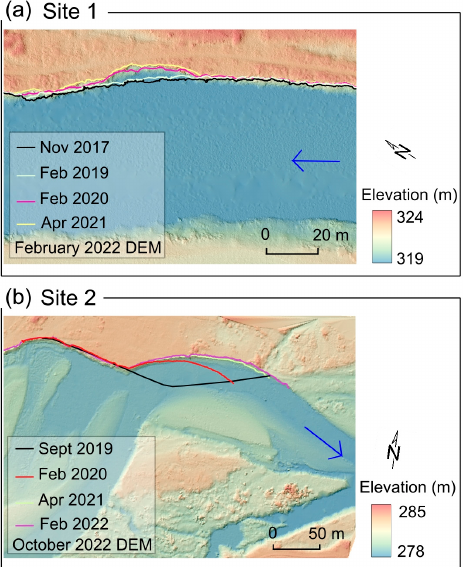
Figure 4. ( a ) Bank retreat at Site 1. November 2017: 2 months after work; February 2019: 17 months after work; February 2020: 29 months after work; April 2021: 43 months after work; February 2022: 53 months after work. ( b ) Bank retreat at Site 2. September 2019: 0 months after work; February 2020: 5 months after work; April 2021: 19 months after work; February 2022: 29 months after work; October 2022: 37 months after work. The blue arrow indicates the flow direction.